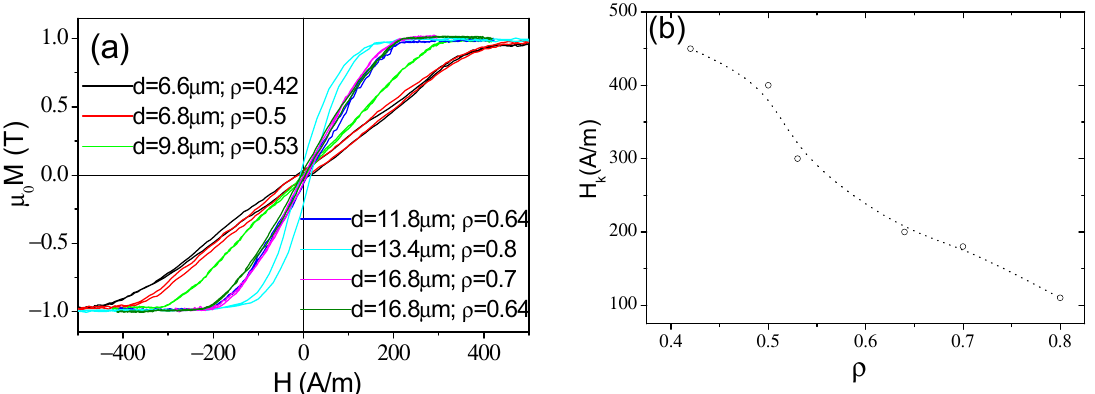
Figure 6. Hysteresis loops of Co 67.1 Fe 3.8 Ni 1.4 Si 14.5 B 11.5 Mo 1.7 microwires with di ff erent geometry ( a ) and H k ( ρ ) dependence for the same microwires ( b ). (Reproduced with permission from [12] Copyright © 2015 Elsevier B.V).